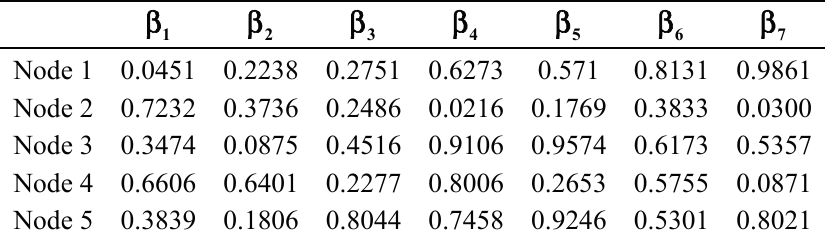
Table 6. The cross-layer parameters of multiple constraints.